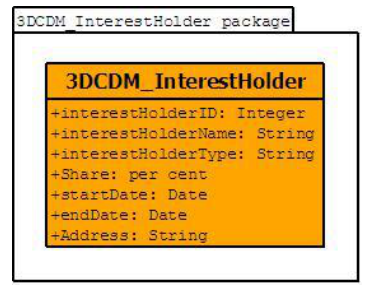
Figure 4: 3DCDM_InterestHolder Package